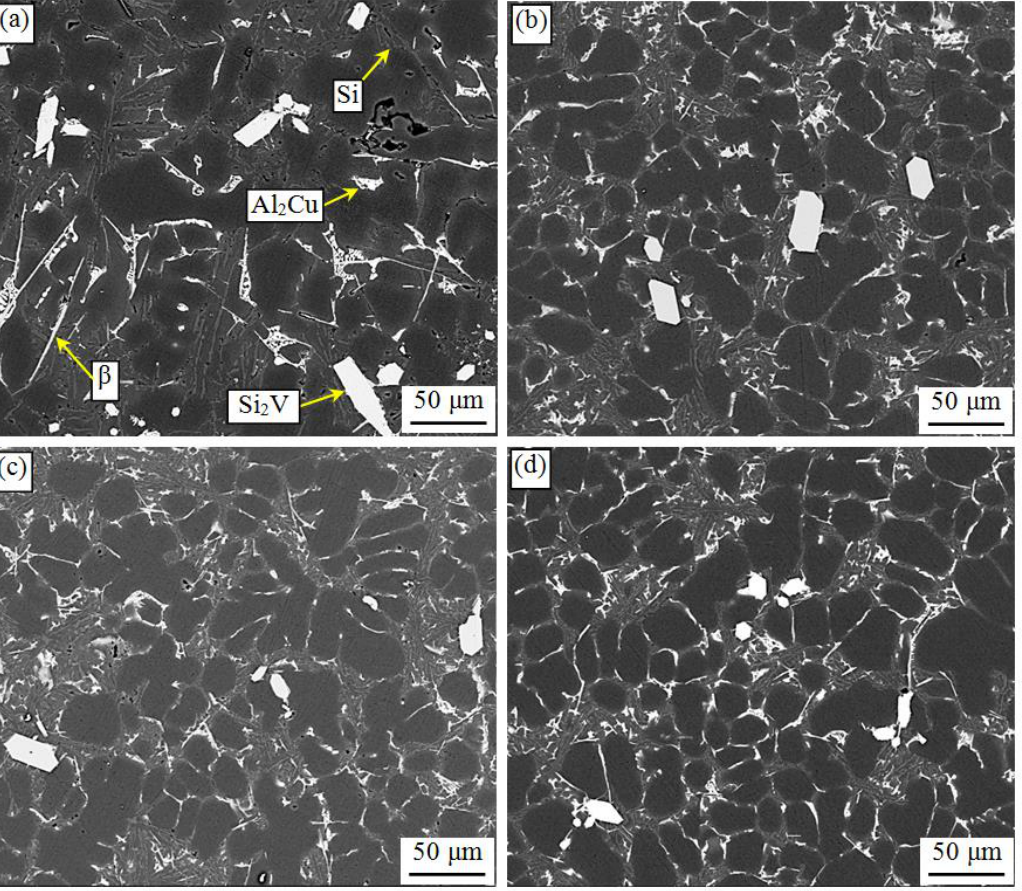
Figure 13. SEM micrographs of as-cast HPRSC A3 alloy treated by UV-ES compound field (β stands for β-Al 5 FeSi): ( a ) 0 MPa; ( b ) 100 MPa; ( c ) 200 MPa; ( d ) 400 MPa.